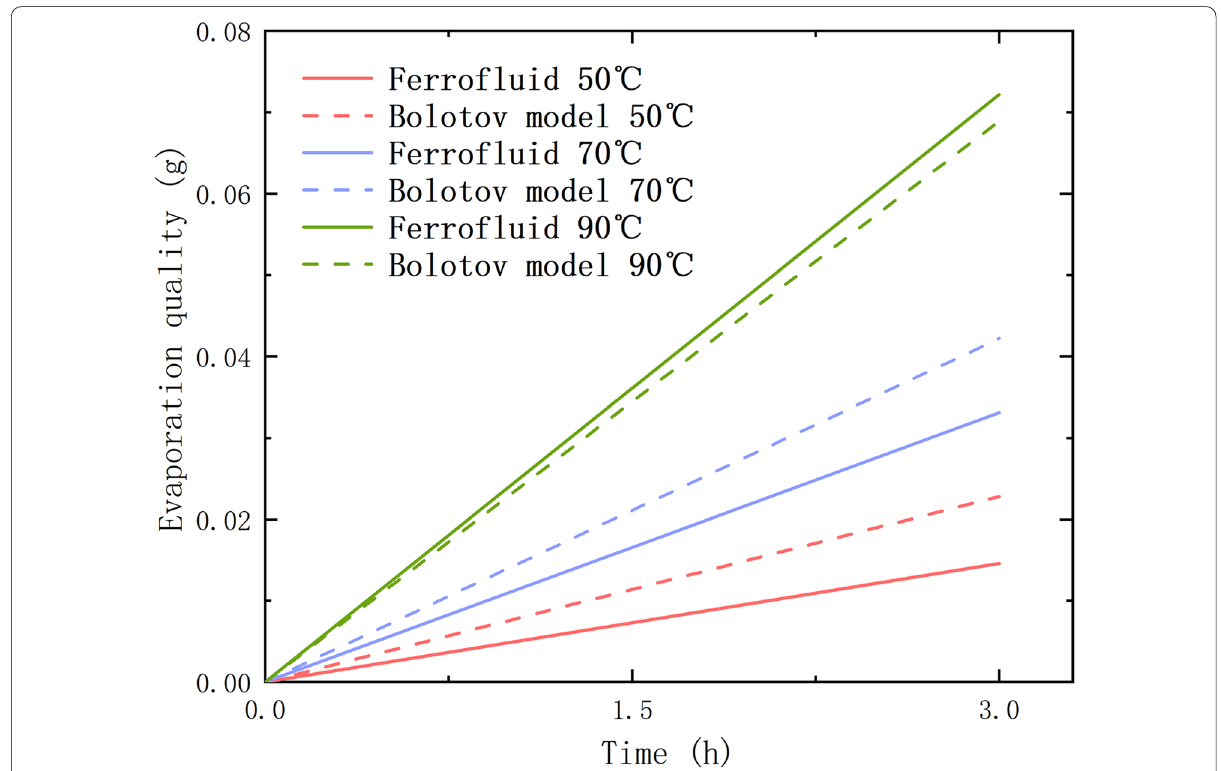
Figure 5 Prediction of the evaporation rate of a ferrofluid at different